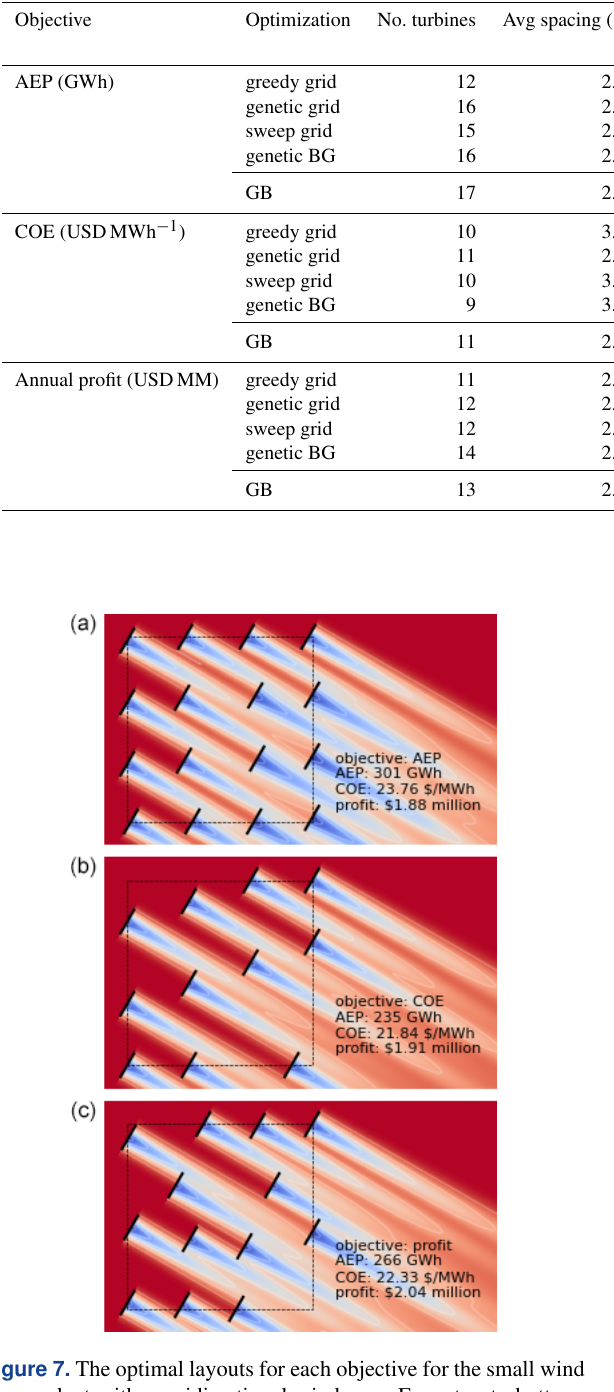
Table 2. Complete optimization results for the small wind power plant with unidirectional wind rose. “BG” indicates the boundary-grid design variables, and “GB” stands for the gradient-based optimization. The bold entries indicate the best and worst solutions for each objective.